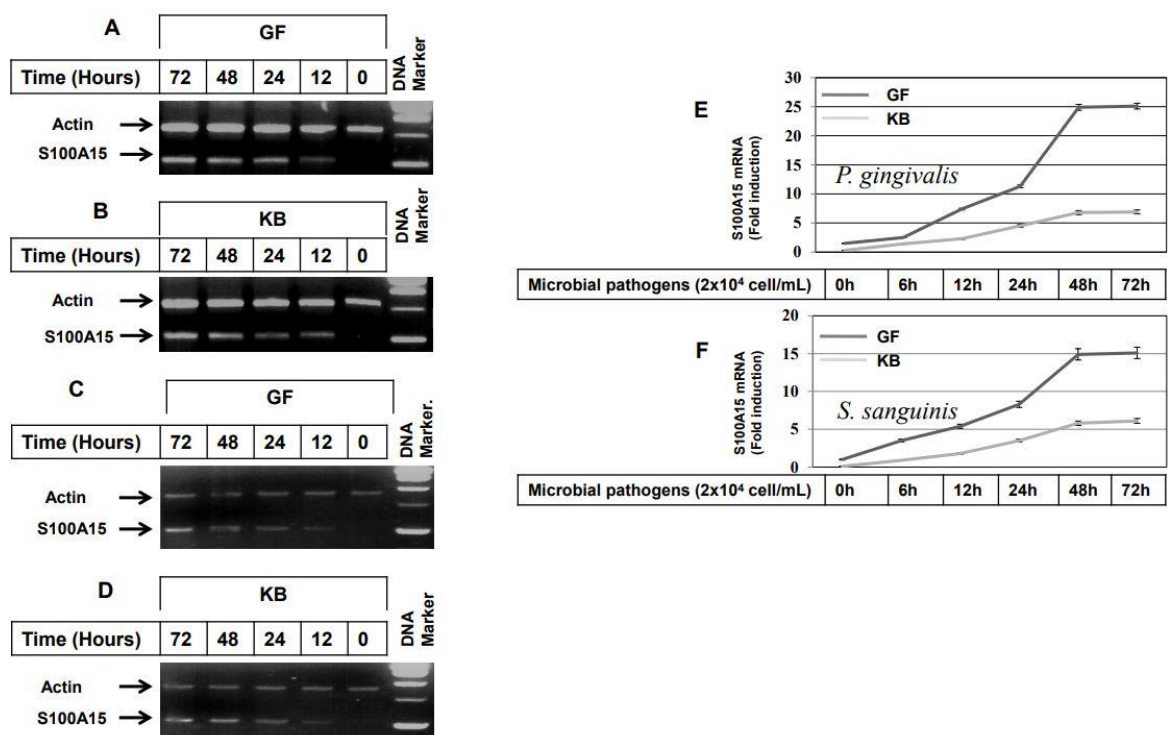
Figure 1. Induction of S100A15 expression in oral mucosa by both gram − and gram + oral bacterial pathogens. ( A – D ) RT-PCR expression of S100A15 by the stimulation of GF ( A ) and KB ( B ) cells with lipopolysaccharides (LPS) at a concentration of 100 ng/mL for regulated time intervals up to 72 h; expression of S100A15 by the stimulation of GF ( C ) and KB ( D ) cells with lipoteichoic acid (LTA) at a concentration of 50 ng/mL for regulated time intervals up to 72 h. Total RNAs were extracted from treated cells at different time intervals and subjected to RT-PCR analysis as described under material and methods. The RT-PCR products were analyzed on 2% agarose stained with ethidium bromide. The leader DNA 1.0 kbp was used as a DNA marker. Actin was used as an internal control. Data are representative of three independent experiments performed separately. ( E , F ) qRT-PCR expression of S100A15 by the stimulation of GF and KB cells with either heat-inactivated P. gingivalis ( E ) or heat-inactivated S. sanguinis ( F ) microbial pathogens (MPs) for regulated time intervals up to 72 h. Total RNA was extracted from treated cells at different time points and subjected to qRT-PCR analysis as described under material and methods. The represented data are the mean ± SD of three independent experiments performed in duplicate.